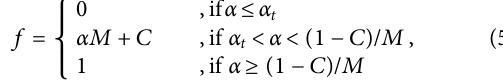
Frontiers in Earth Science |